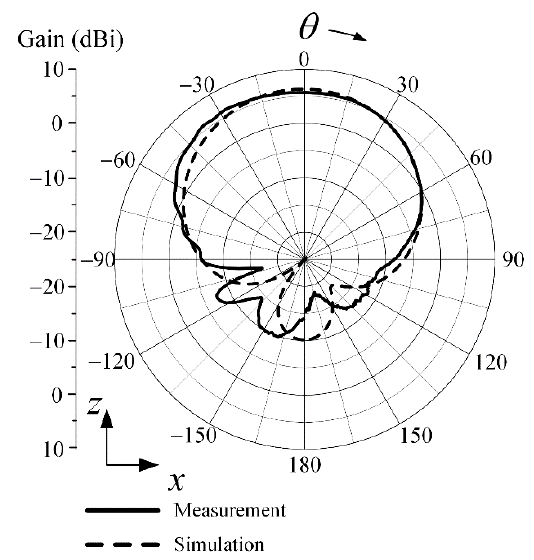
Figure 4. Radiation patterns of the proposed antenna.